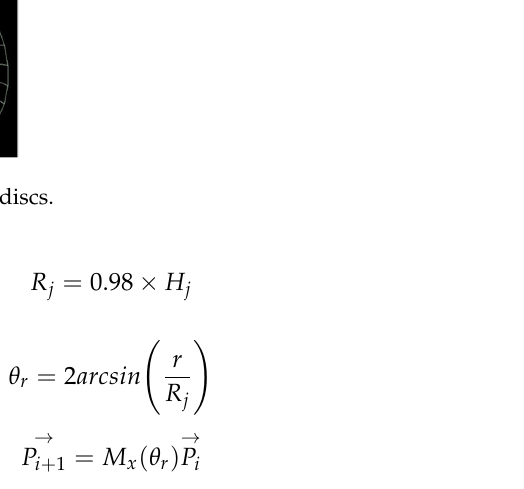
Figure 6. Gear feature parameter detection. where j R is the radius of the track of the detection ball.